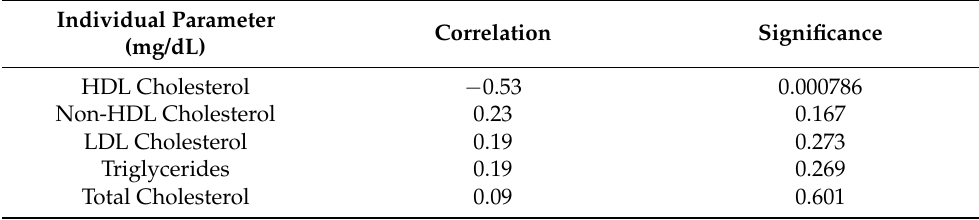
Table 2. Correlations between individual lipid parameters and mean aortic tracer